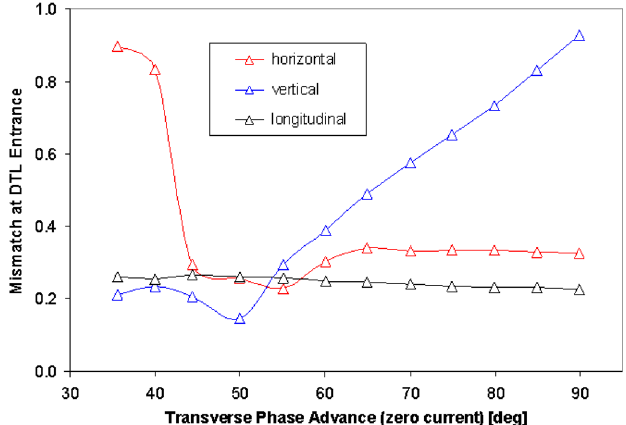
FIG. 21. (Color) Mismatch between beam 95%-rms-Twiss pa- rameters and Twiss parameters for rms-matched injection into the DTL as a function of the current phase advance (cid:4) o